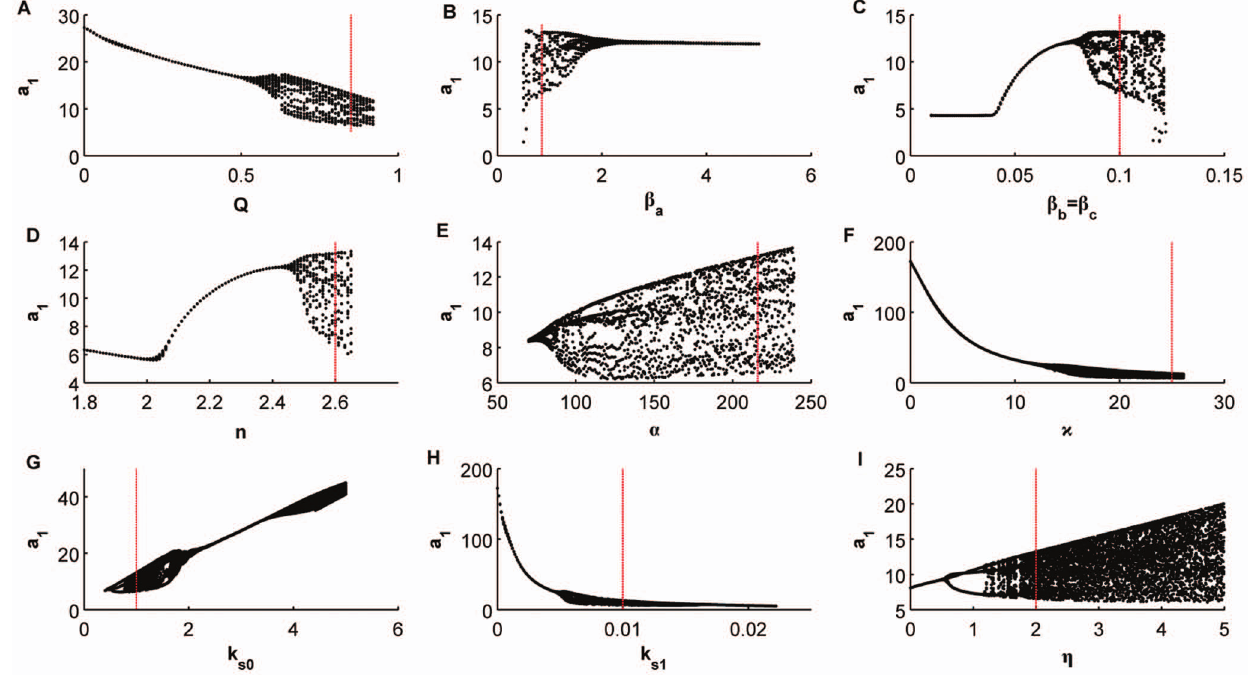
Figure 1. Bifurcation diagrams versus the different control parameters. (A) Q, (B) b a , (C ) b b , (D) n , (E) a , (F) k , (G) k s 0 , (H) k s 1 , (I) g .